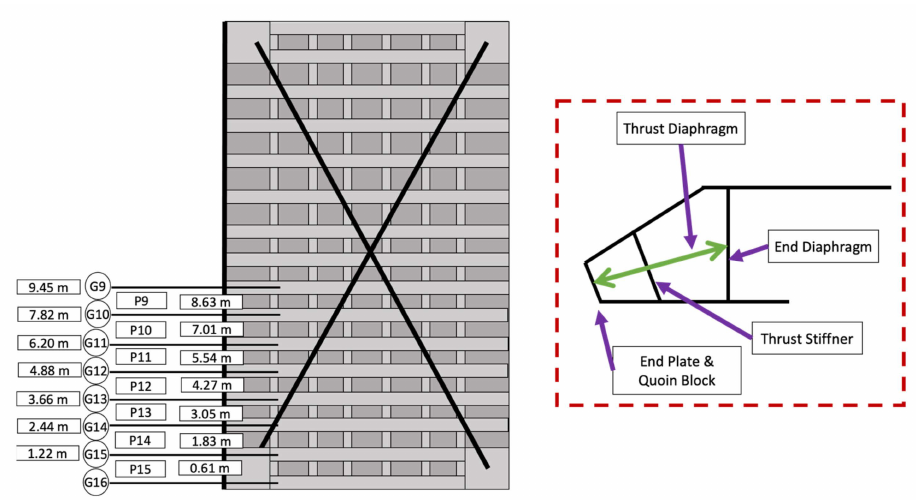
Figure 12. Horizontal Paths along the thrust diaphragm aligned with Girders 9, 10, 11, 12, 13, 14, and 15; and with the centerline of Panel